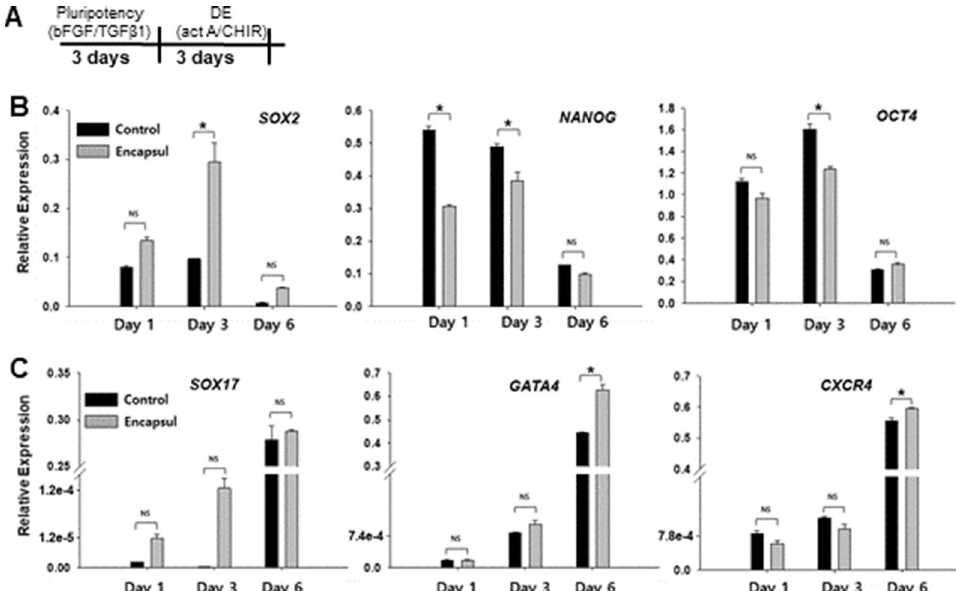
Figure 6. Evaluation of plurpotency maintenance and endodermal differentiation of hPSC spheroids. ( A ) Workflow of the pluripotency maintenance and endodermal differentiation experiment. ( B ) RT-PCR analysis of pluripotency genes OCT4, SOX2, NANOG. For statistical analysis n = 4, p < 0.05. ( C ) RT-PCR analysis of endodermal genes SOX17, GATA4, CXCR4. (n > 4, p <